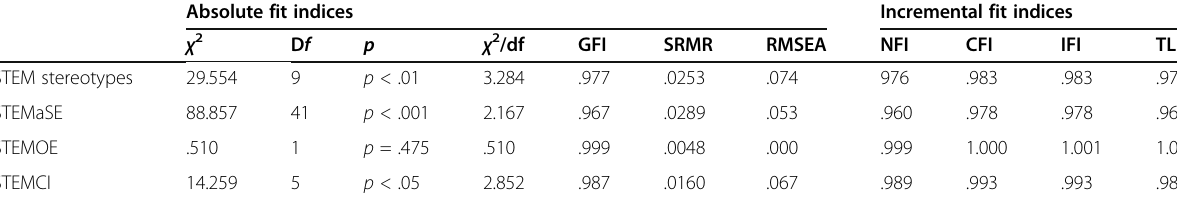
Table 2 Fit indices of the SEM measurement (CFA) models of the instruments Absolute fit